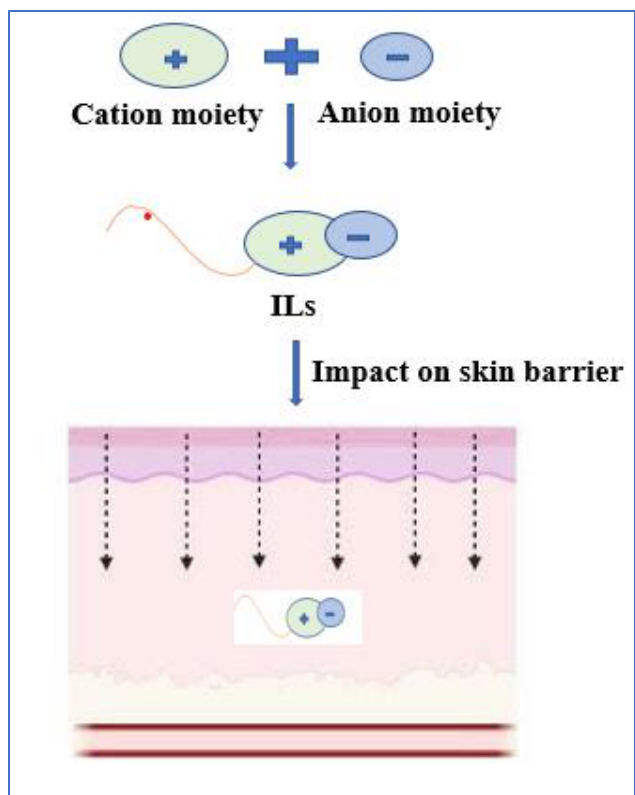
Figure 8. Formation of ILs and the effect on the skin